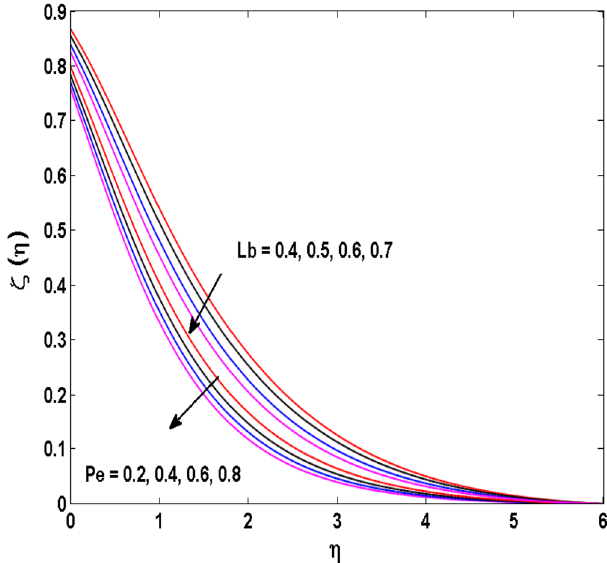
Figure 17. Variations of Pe and Lb to ζ (η) .